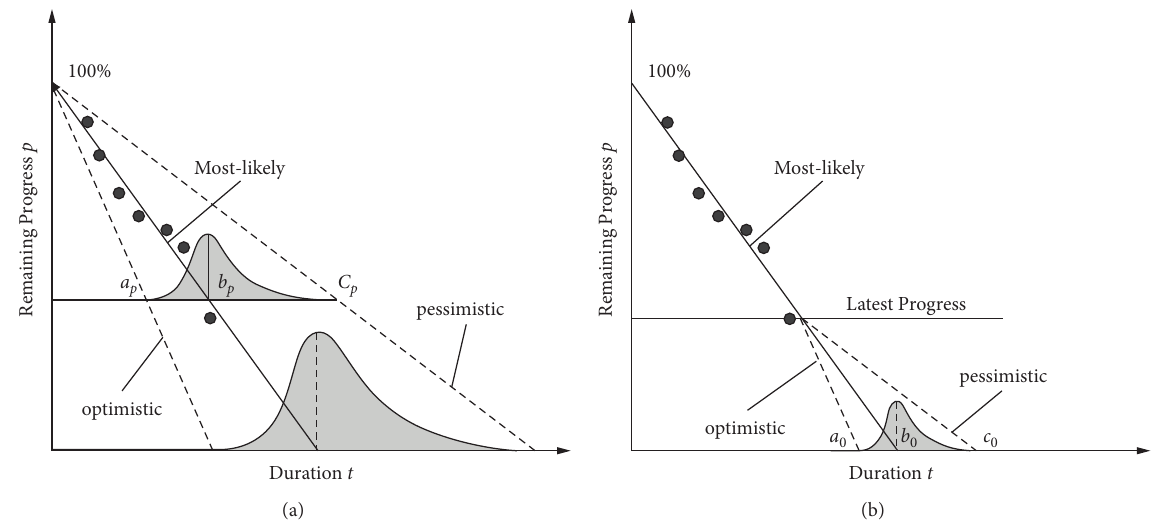
Figure 3: Assumptions in our two-step estimation. (a) Step 1: working rate estimation. (b) Step 2: final distribution estimation.